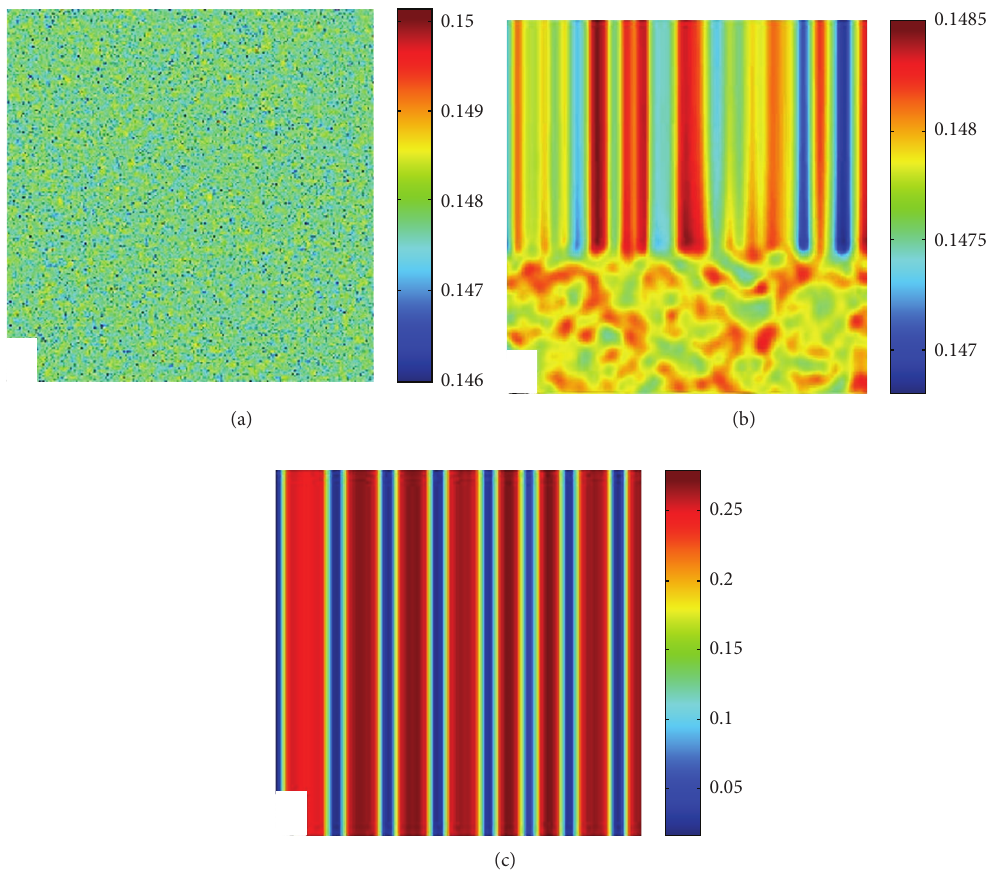
Figure 9: Snapshots of contour diagrams of the time evolution of algae at different points in time with 𝑁 = 0.31, 𝐷 2 = 1.25, V = 2.5 . (a) 0 iterations, (b) 1500 iterations, and (c) 100000